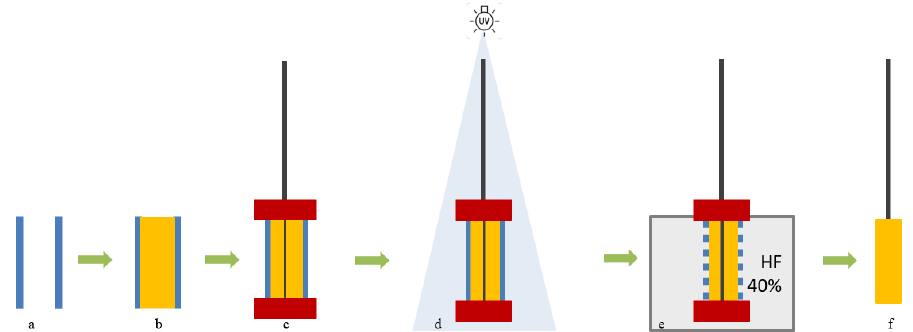
Figure 3. Representation of the fiber coating procedure using a virtual longitudinal cut at the center of the material; ( a )—empty ST; ( b )—ST filled with M1; ( c )—two red rubber stoppers were placed at the ends of the ST with steel wire in the middle; ( d )—UV polymerization step; ( e )—ST is destroyed by HF; and, ( f )—final material coated on top of the steel wire.